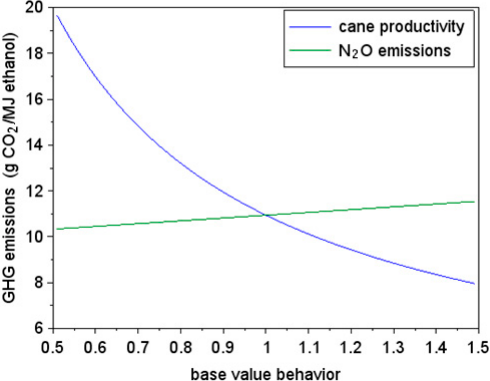
Figure 9. GHG behavior of the variable cane productivity and N 2 O emissions (50%–150%).